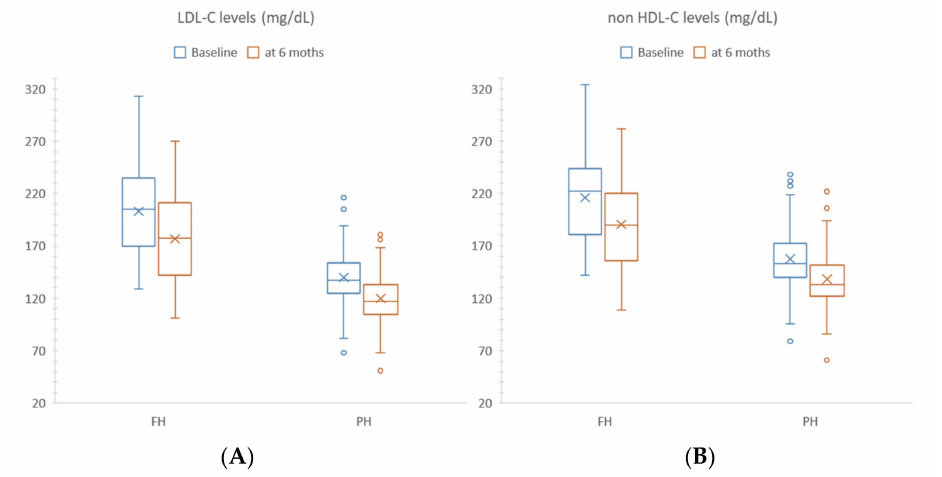
Figure 2. LDL-C ( A ), non-HDL-C ( B ) Box-plot at baseline (blue) and at 6 months follow-up (orange) in familial hypercholesterolemia (FH) and polygenic hypercholesterolemia (PH) in the Respon- der Group.